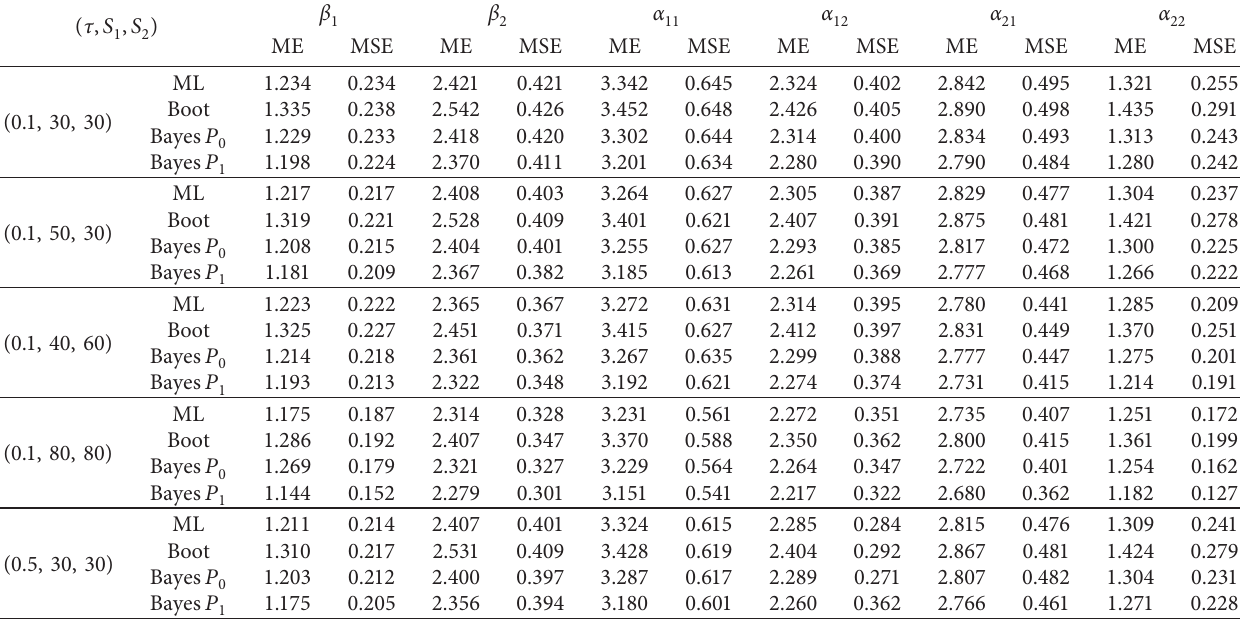
Table 7: The ME and MSEs of ML, boot, and Bayes methods under ω � 1 . 0 , 2 . 0 , 3 . 0 , 2 . 0 , 2 . 5 , 1 . 0 { }